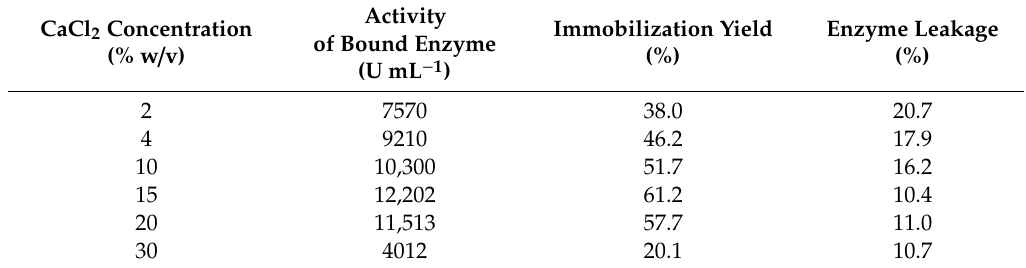
Table 3. E ff ect of the concentration of CaCl 2 on invertase immobilization in alginate-based hydrogel.